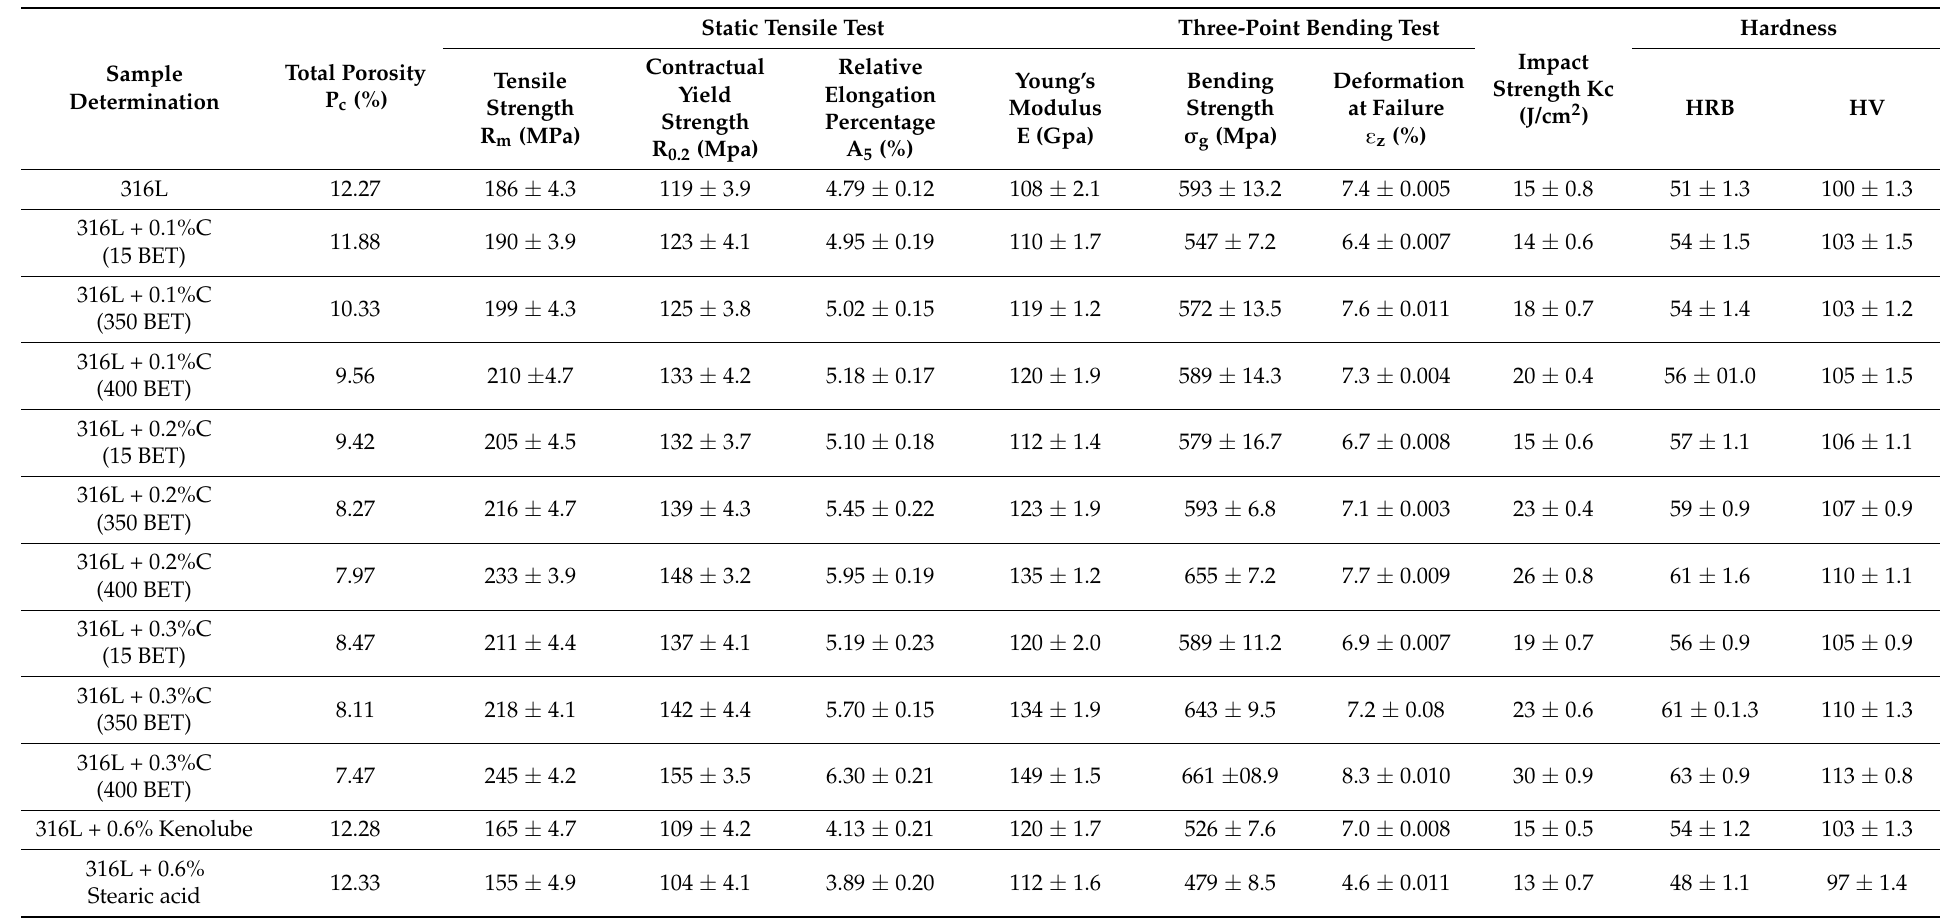
Table 5. The mechanical properties of sinters depend on the percentage composition of the